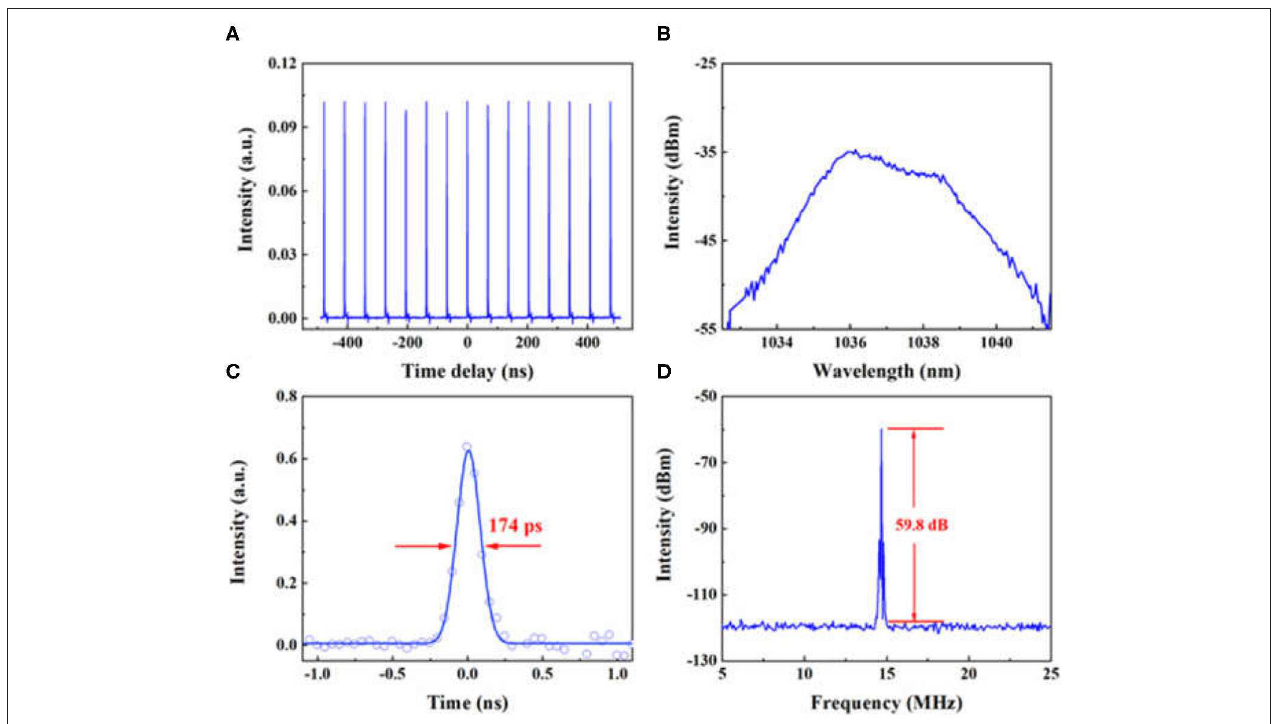
FIGURE 5 | Long-term spectrum measurement results.